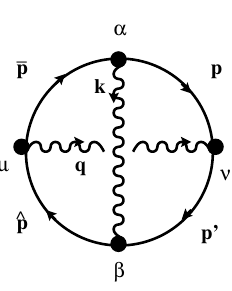
Figure 8 . Parametrization of diagram